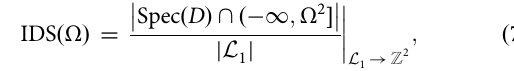
Fig. 4 Spectral properties of lattice with β ¼ π = boundary conditions as a function of θ . The same result is repeated in ( b ), but color-coded by the associated density of states (colorbar). Particular gaps are marked by colored dots and labeled (I – VIII) for reference. c Integrated density of states (IDS) as a function of θ , where the color gradient represents Ω 2